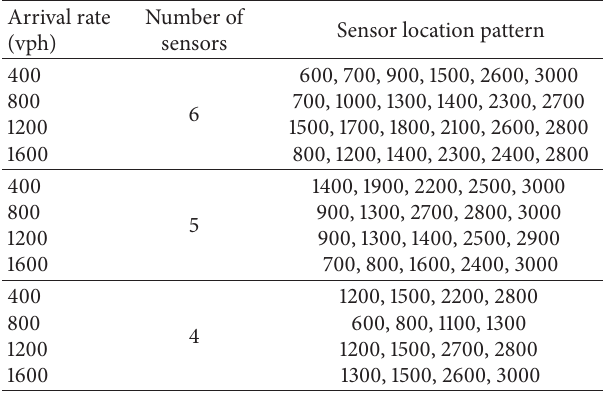
Table 2: Comparison among different arrival rates. Arrival